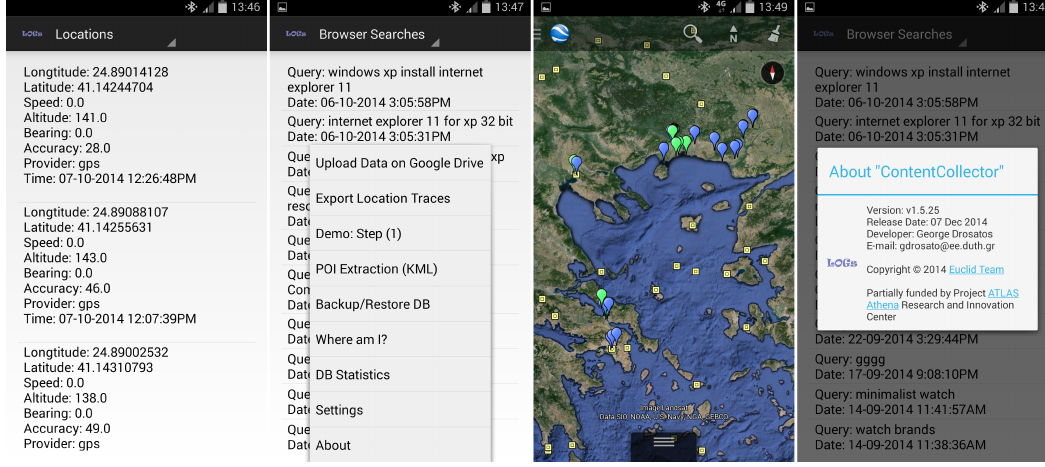
Figure 6. Android app